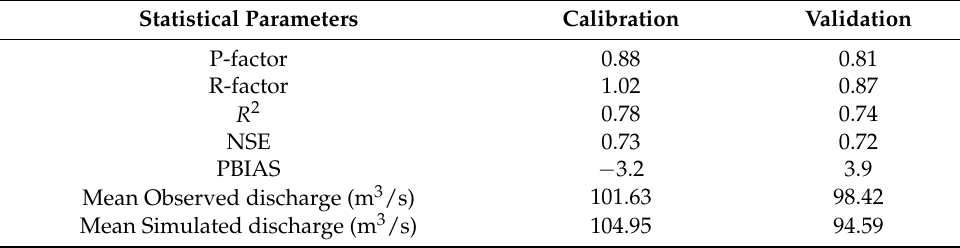
Table 10. Summary of statistical values of calibration, validation and uncertainty of streamflow